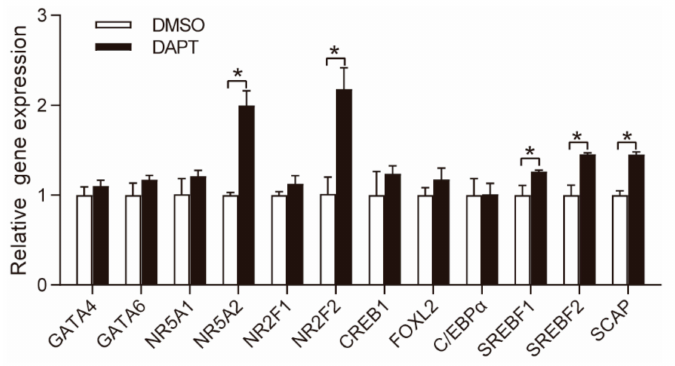
Figure 3. E ff ects of DAPT treatment on the gene expression of key TFs involved in steroidogenesis. Primary pGCs were treated with 25 µ M DAPT for 48 h. * means significant di ff erence at p <